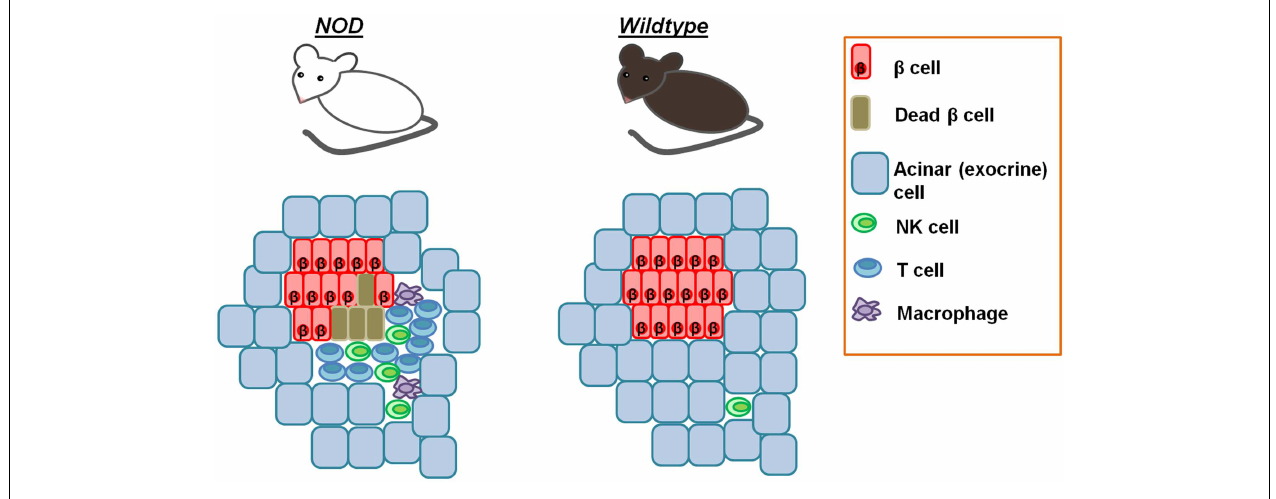
starting at the earliest stages of insulitis.This explains why diabetes does not develop in all individuals, despite the intrinsic ability of NK cells to kill β